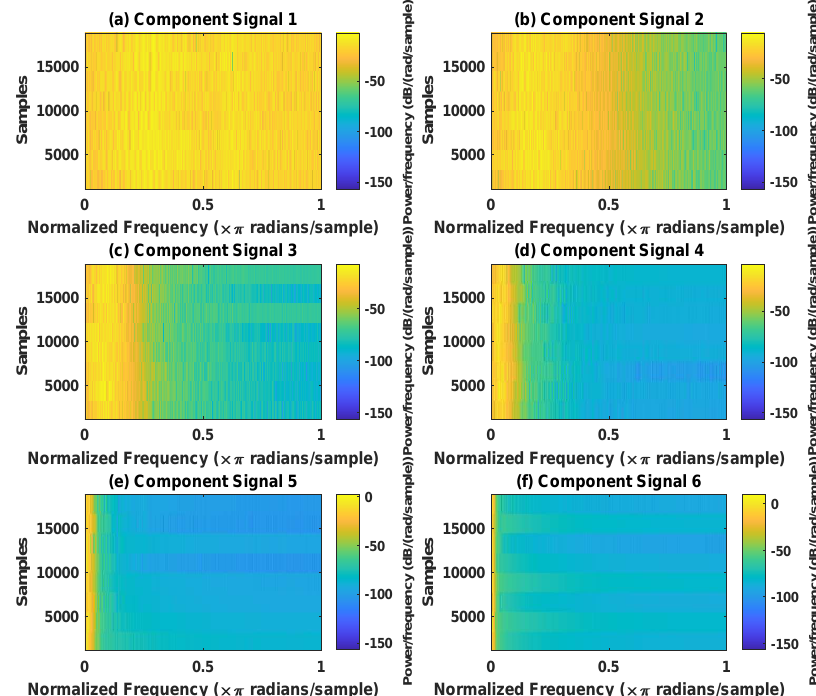
Figure 9. Decomposition results of EMD with m = 16: ( a – f ) time–frequency diagram of 1st to 6th subcomponents, respectively.